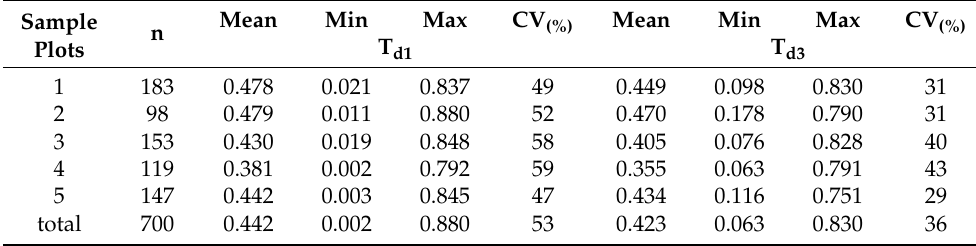
Table 3. The diameter differentiation